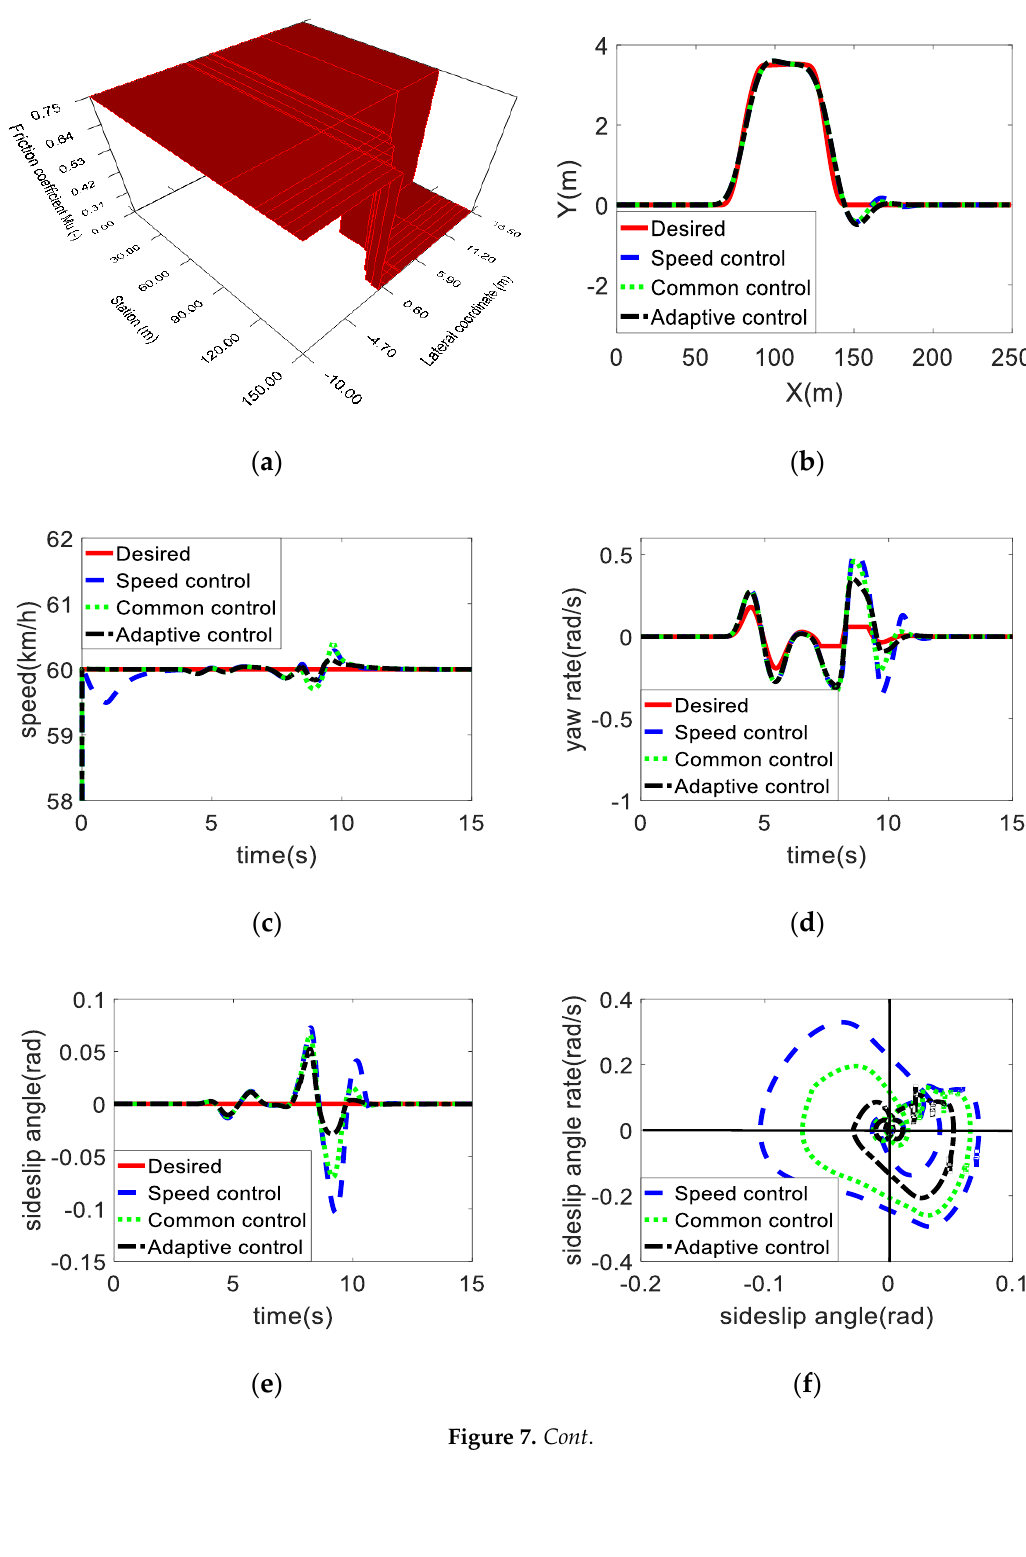
Figure 6. The μ -split road. ( a ) top view. ( b ) driver view.